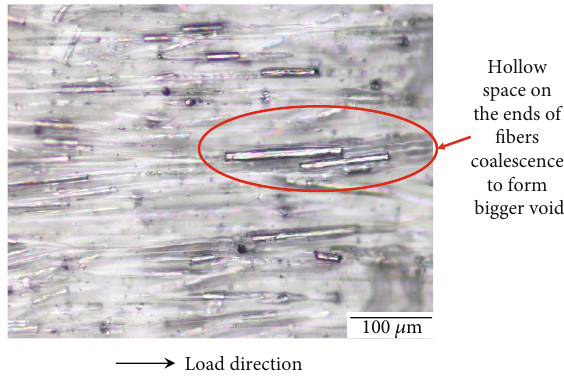
Figure 8: OM image of PP/15SCF composite surface microstructure after the tensile